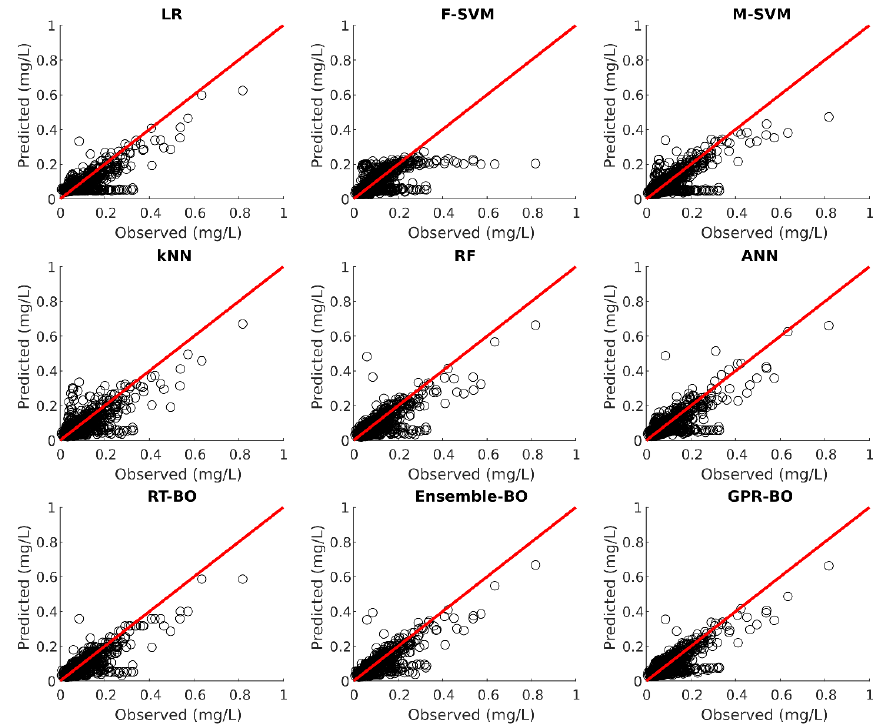
Figure 9. Observed versus predicted daily phosphorus concentration for the Grand using different ML algorithms.